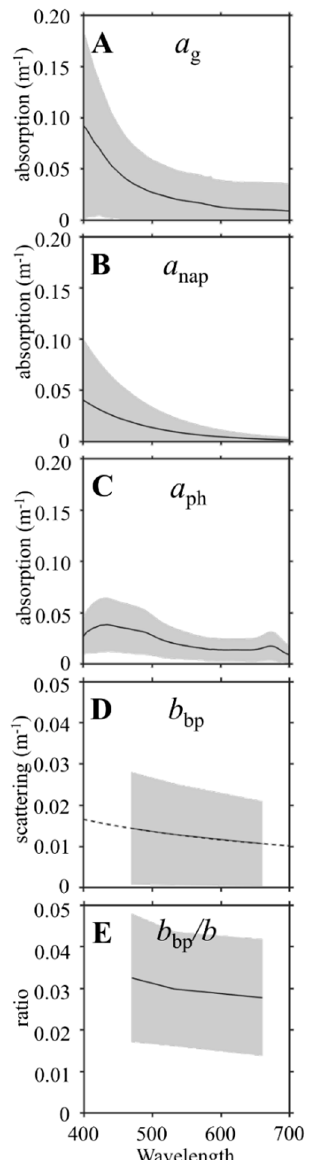
Figure 4. Mean spectra measured across all sites for ( A ) absorption by colored dissolved organic matter ( a g ), ( B ) non-algal particles ( a nap ), and ( C ) phytoplankton ( a ph ), ( D ) particulate backscattering ( b bp ) and ( E ) backscattering ratio ( b bp / b ). Shaded areas are ± 1 standard deviation. The dashed line (D) represents the slope of backscattering Y .